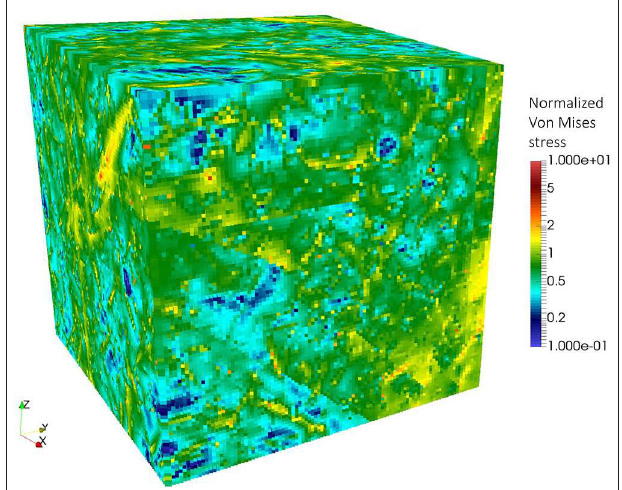
FIGURE 1 | Stress-intensity field generated on a regular grid of size L = 1 and resolution r = 0.01